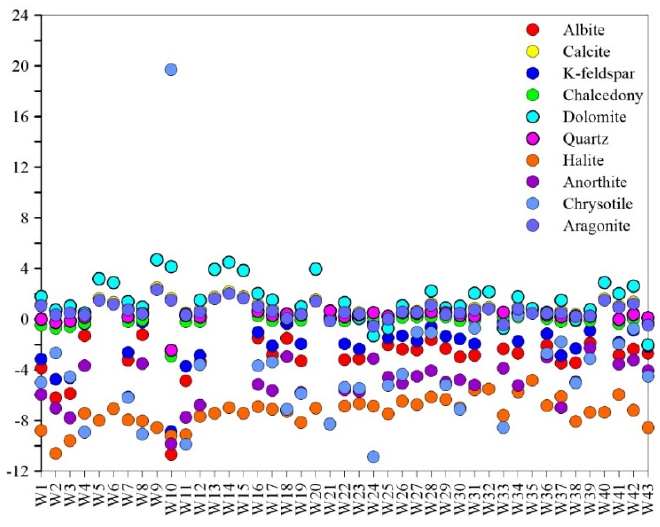
Figure 7. Saturation indices values of groundwater samples with respect to minerals.